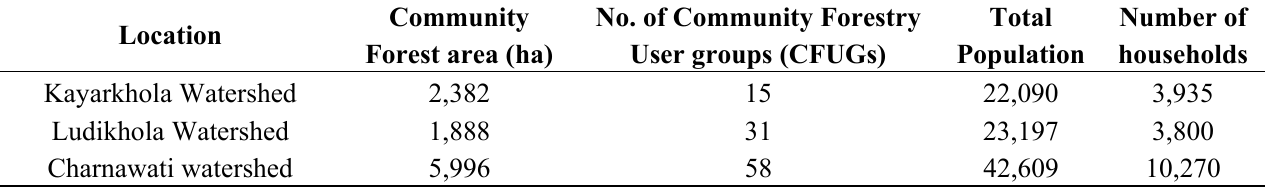
Table 1. Overview of study